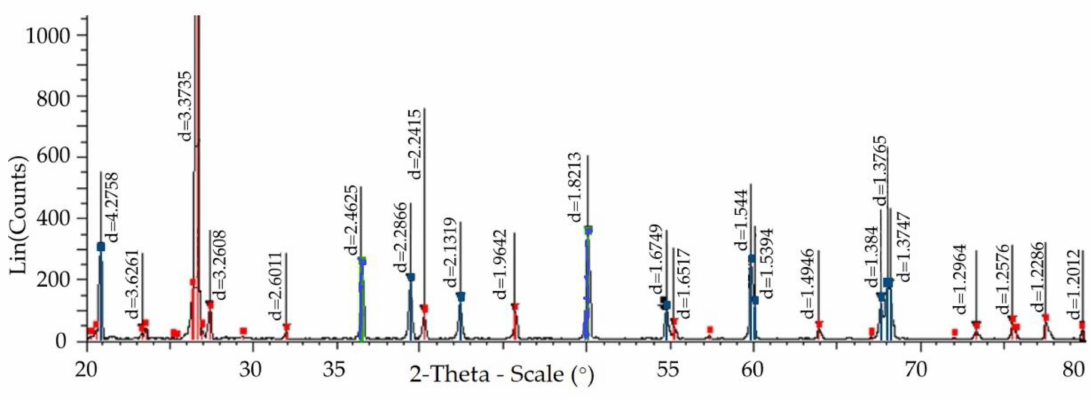
Figure 8. Quartzite diffractogram, taken at 30 ◦